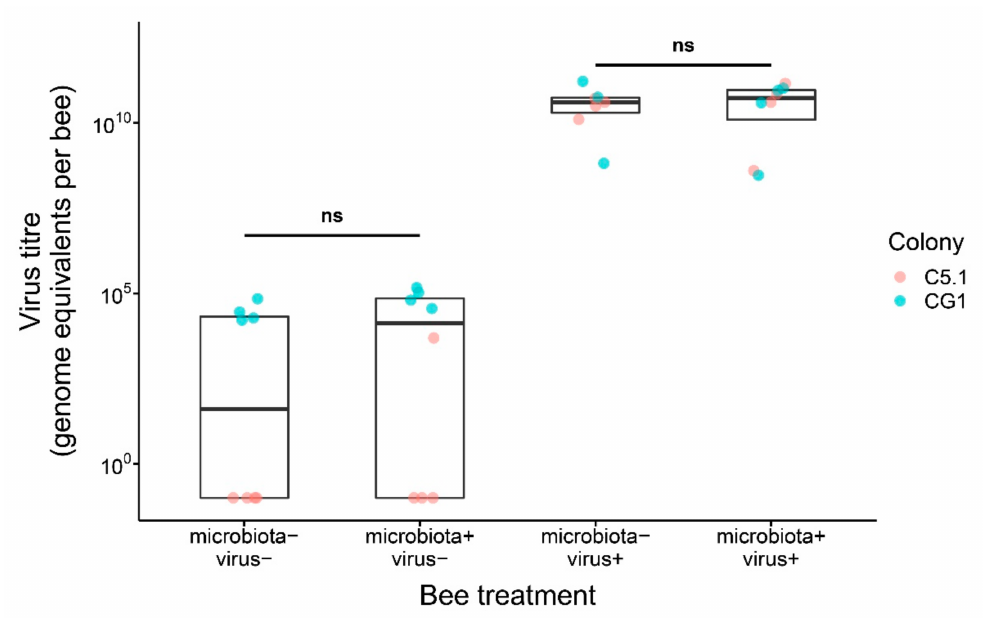
Figure 3. DWV-B virus titer at day 11 in experimental microbiota+ and microbiota- bees that were either fed a virus inoculum (virus+) or not (virus − ) at day 6. Non-significant differences are indicated by “ns” ( p > 0.05). Boxplots show the median and interquartile range. Points represent individual bees, and colors indicate bee source colony of